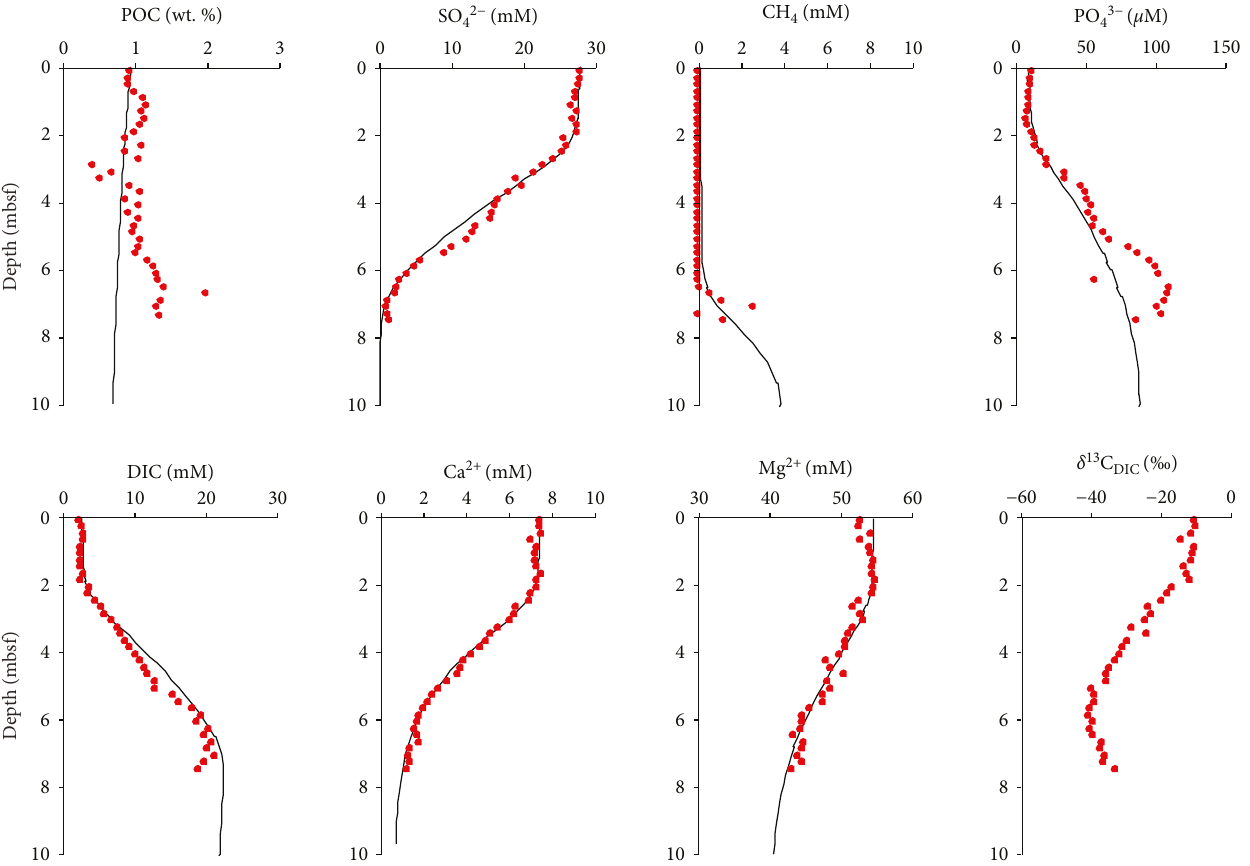
Figure 3: Measured (dots) and simulated (curves) depth pro fi les of core CL44. Down-depth concentration of POC, SO 42- , CH Ca 2+ , Mg 2+ , and δ 13 C is DIC